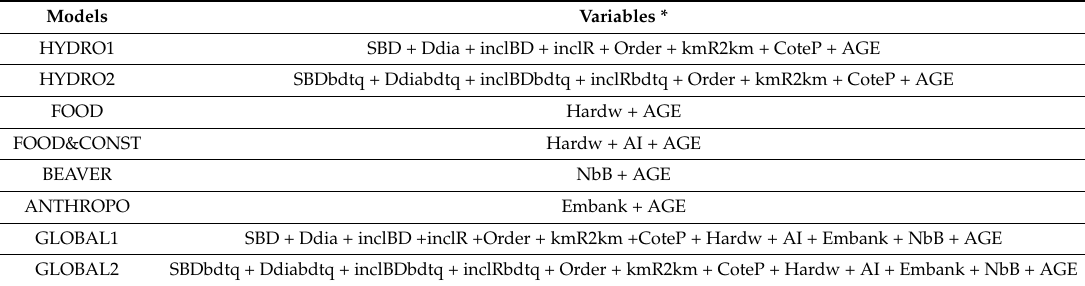
Table 1. Variables included in candidate models to test different hypotheses explaining the presence of